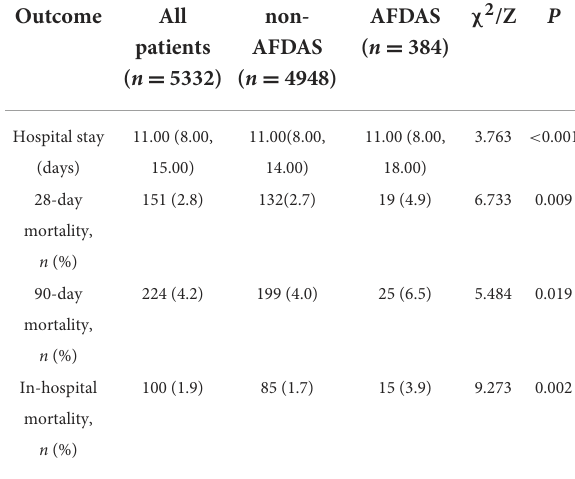
TABLE 5 Outcomes in patients with and without